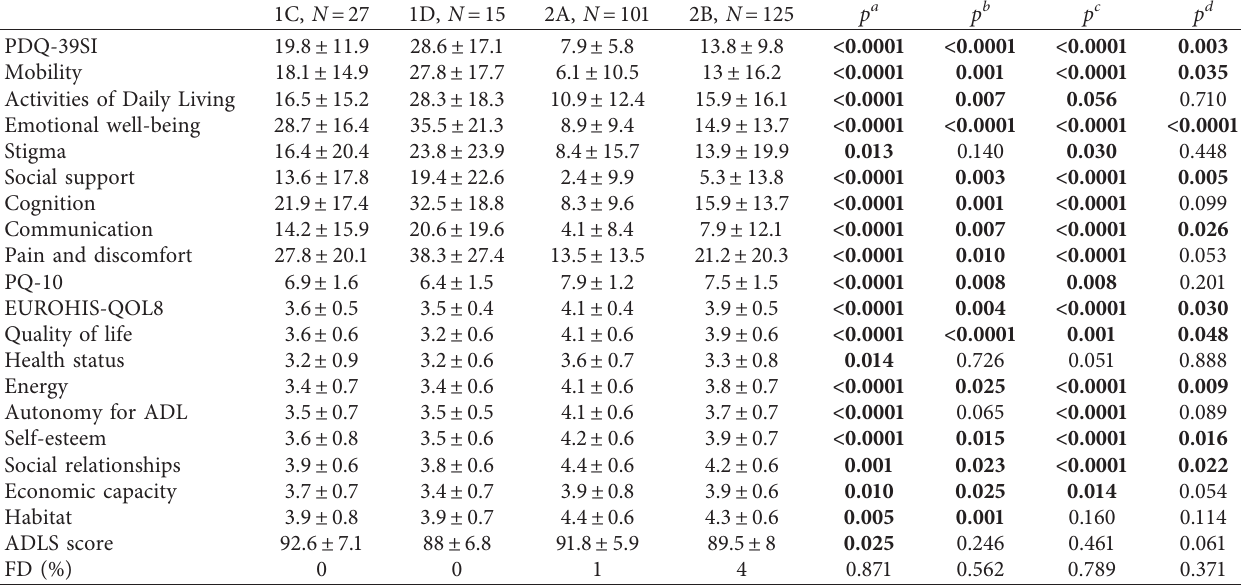
Table 3: Quality of life (PDQ-39SI and EUROHIS-QOL8) and disability (ADLS score) in patients with stages 1C, 1D, 2A, or 2B of the HY-NMSB